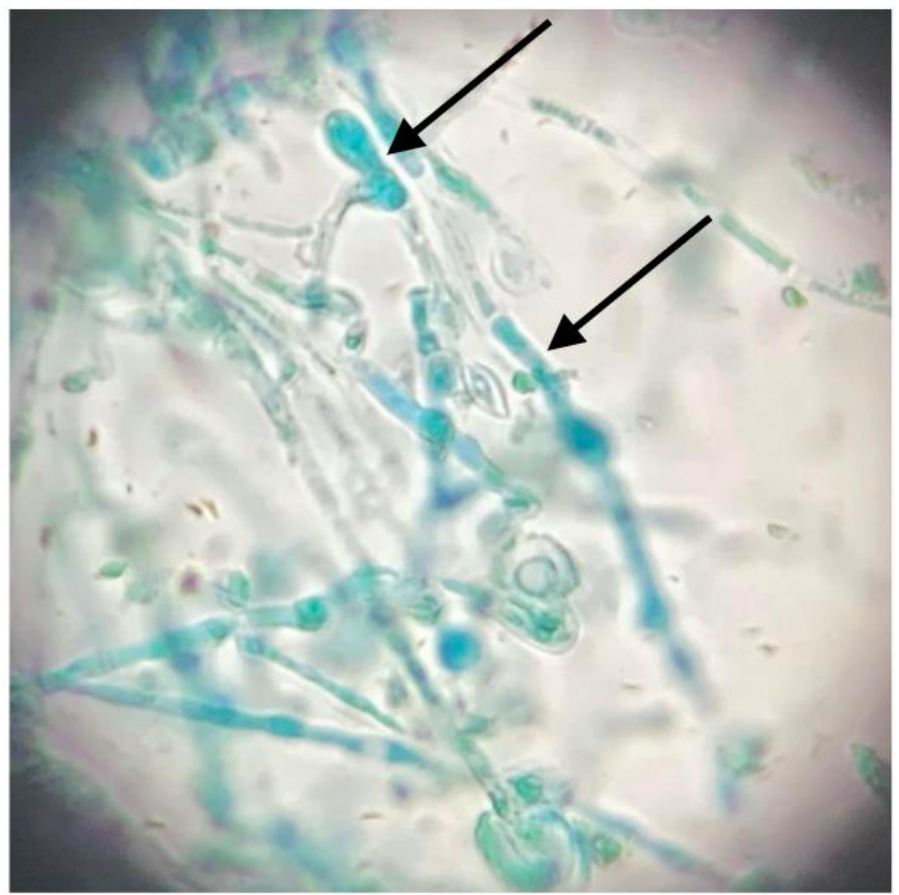
Figure 4. Microscopic picture of microculture: numerous microconidia, including club-shaped ones (pointed by black arrows). Courtesy of Prof. J. C. Szepietowski. (pointed by black arrows). Courtesy of Prof. J. C.